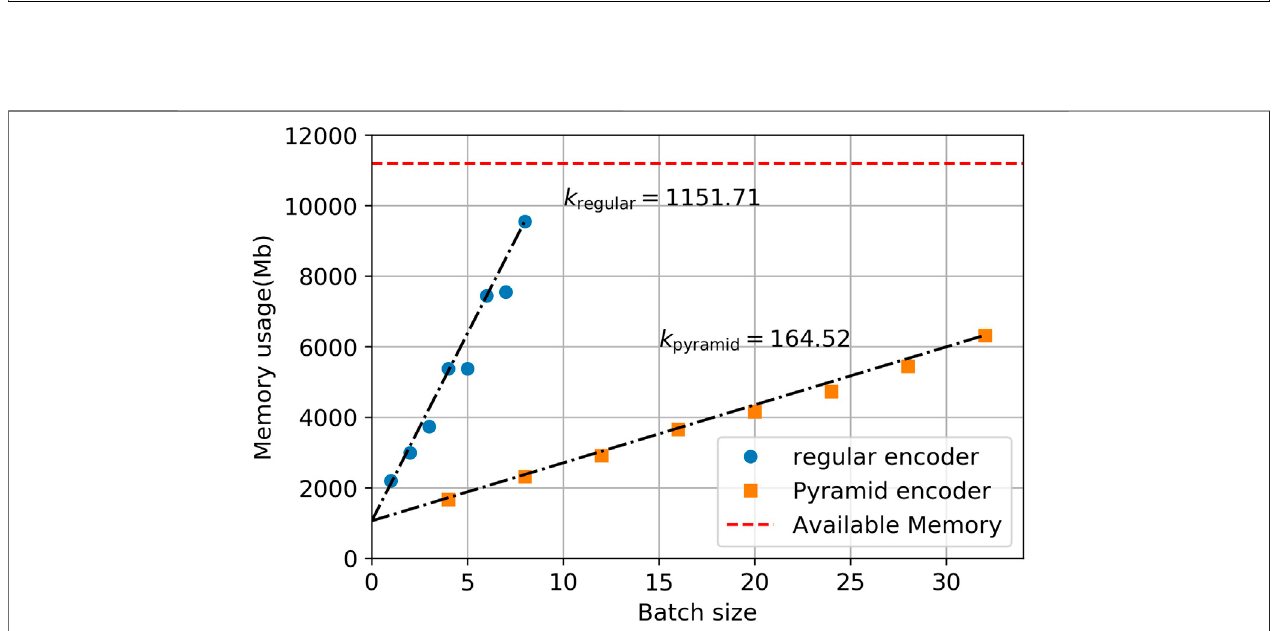
FIGURE 4 | Learning curve of GRU with Luong ’ s general attention, comparing regular encoder to pyramid encoder. Pyramid encoder model shows fast converging speed.